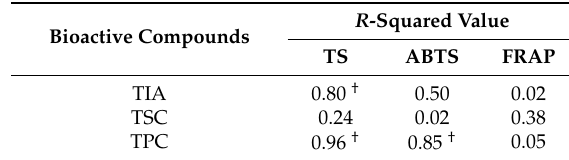
Table 3. Correlations between bioactive compounds with total solids and antioxidant activity of defatted Gac seed